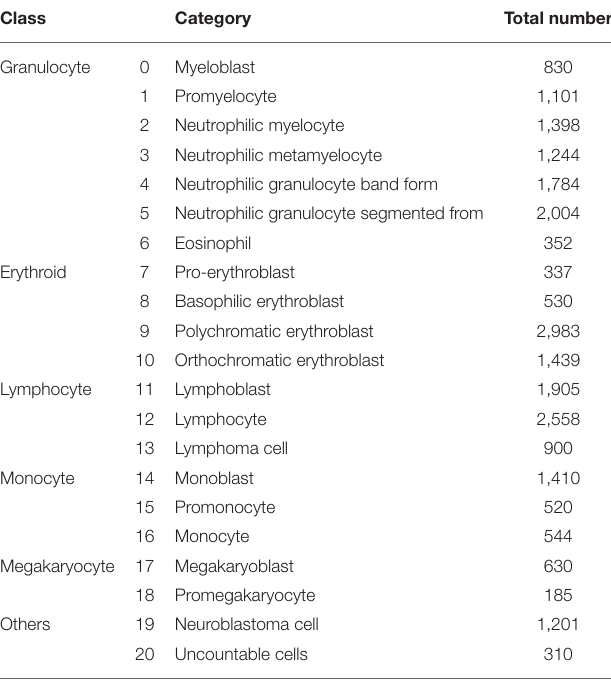
TABLE 1 | The cell types and total numbers of cells of each class in the